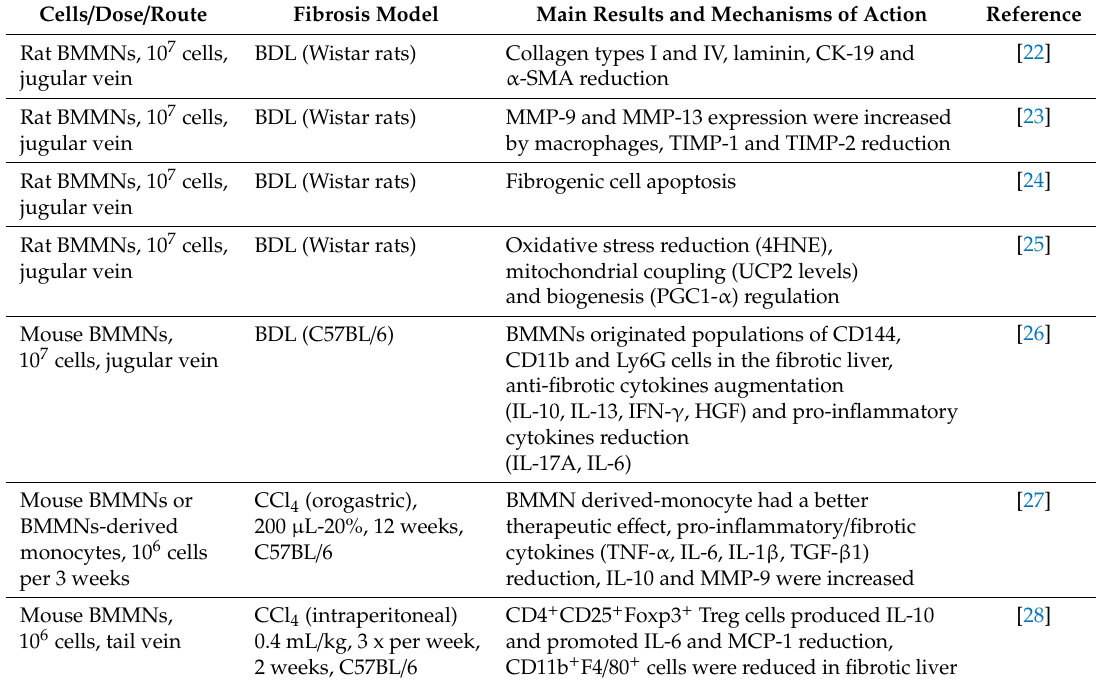
Table 1. Experimental liver fibrosis and bone marrow mononuclear cells